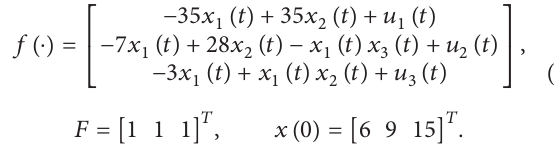
Figure 2: Results of Example 1 with different 𝜆 0 .